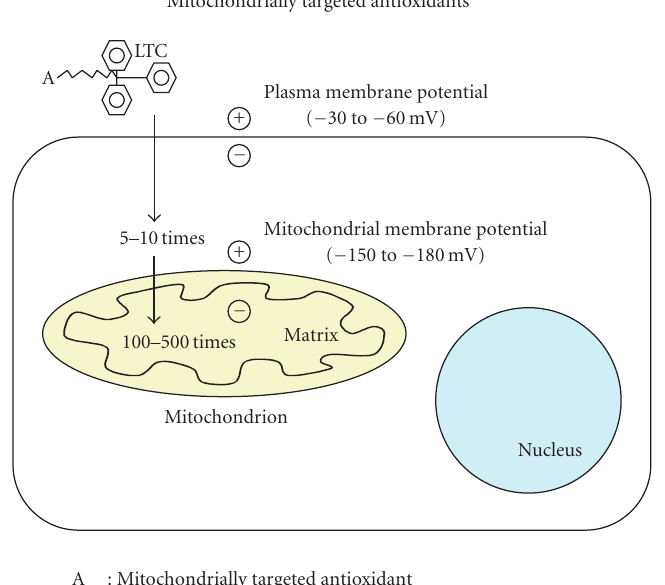
Figure 2: Illustration of mitochondrially targeted antioxidants. A generic mitochondria-targeted antioxidant is shown constructed by the covalent attachment of an antioxidant molecule to the lipophilic triphenylphosphonium cation. Antioxidant molecules accumulate 5- to 10-fold in the cytoplasm, which is driven by the plasma membrane potential, and then further accumulate several hundred-fold in the